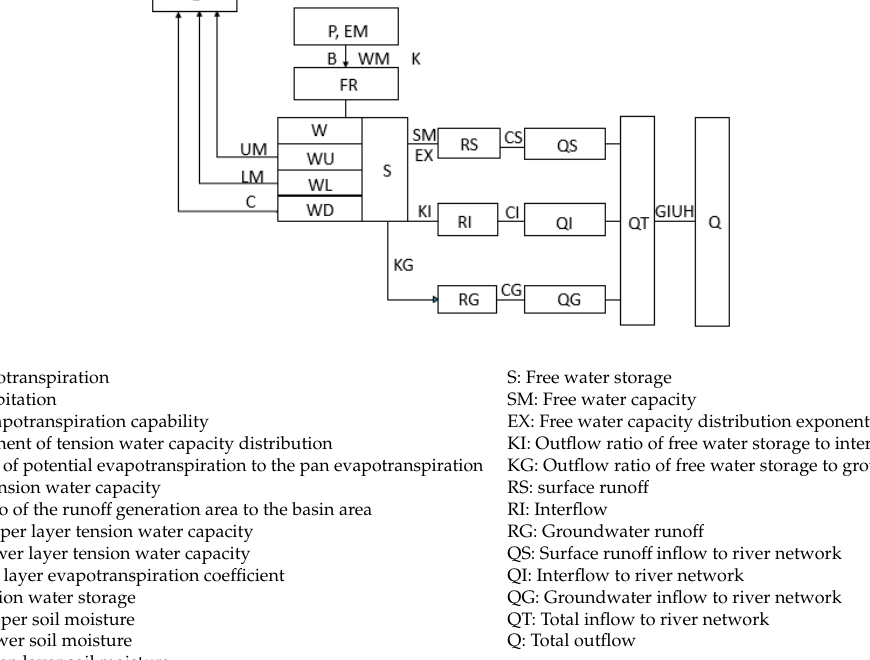
Figure 2. The structure of modified Xin’anjiang (XAJ) model couple with geomorphologic instantaneous unit hydrograph (GIUH) in this study (GIUH is supposed to replace the former method to calculate the stream flow routing), and the explanation of all the items in the figure.